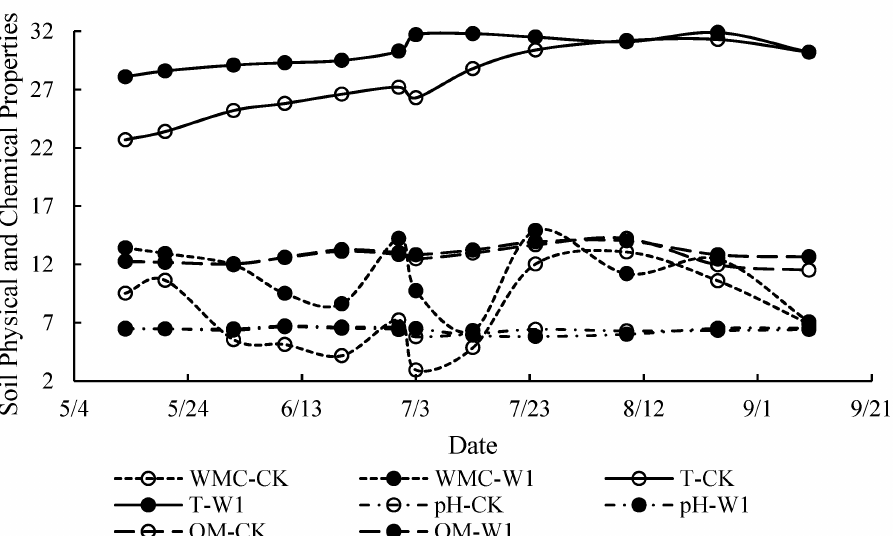
Figure 3. Variation of soil physical and chemical properties at the depth of 0–20 cm in millet farmland under different irrigation modes (WMC-CK, WMC-W1, T-CK, T-W1, pH-CK, pH-W1, OM-CK OM- W1 means the soil water moisture content of CK, the soil water moisture content of W1, the soil temperature of CK, the soil temperature of W1, the soil pH of CK, the soil pH of W1, the soil organic matter of CK, and the soil organic matter of W1,